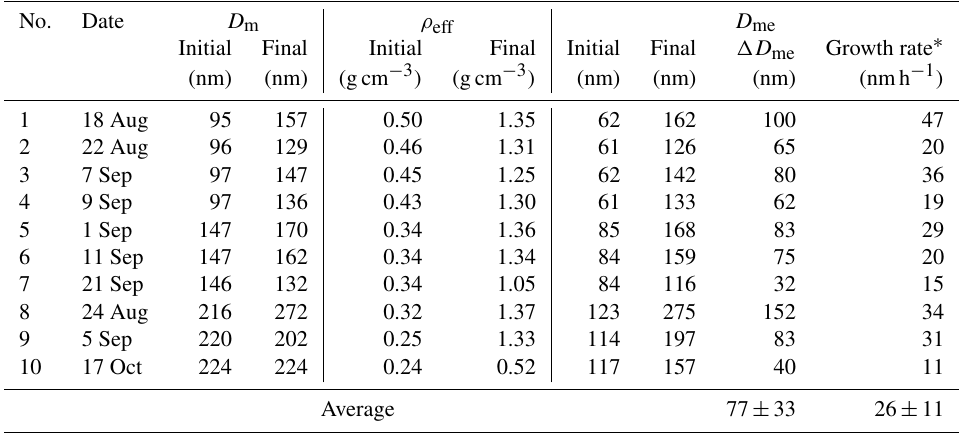
Table 2. Summary of particle properties for BC ageing experiments conducted in Beijing. D m , ρ eff and D me represent the mobility diameter, effective density and mass equivalent diameter.